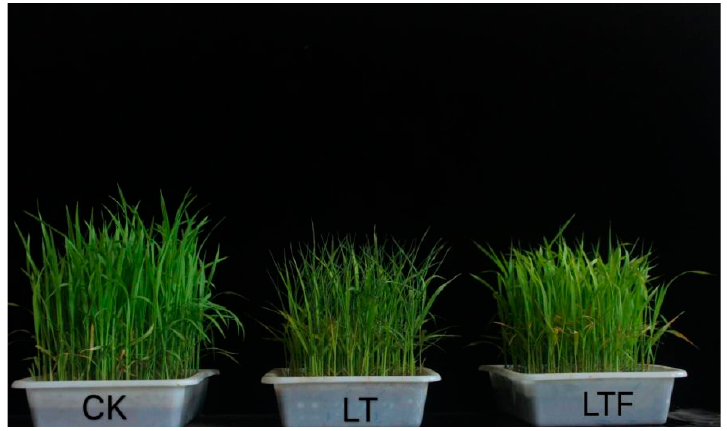
Figure 1. Zhongjiazao 17 Phenotype under different treatments. LT, low temperature treatment; LTF, low temperature flooding; CK, control.